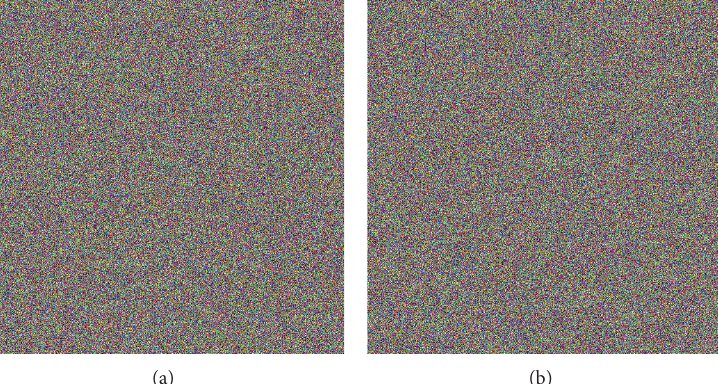
Figure 3: Decryption of Image 4.2.05 Airplane (F-16): (a) encrypted with key K1 and decrypted using key K2 and (b) encrypted with key K1 and decrypted using key